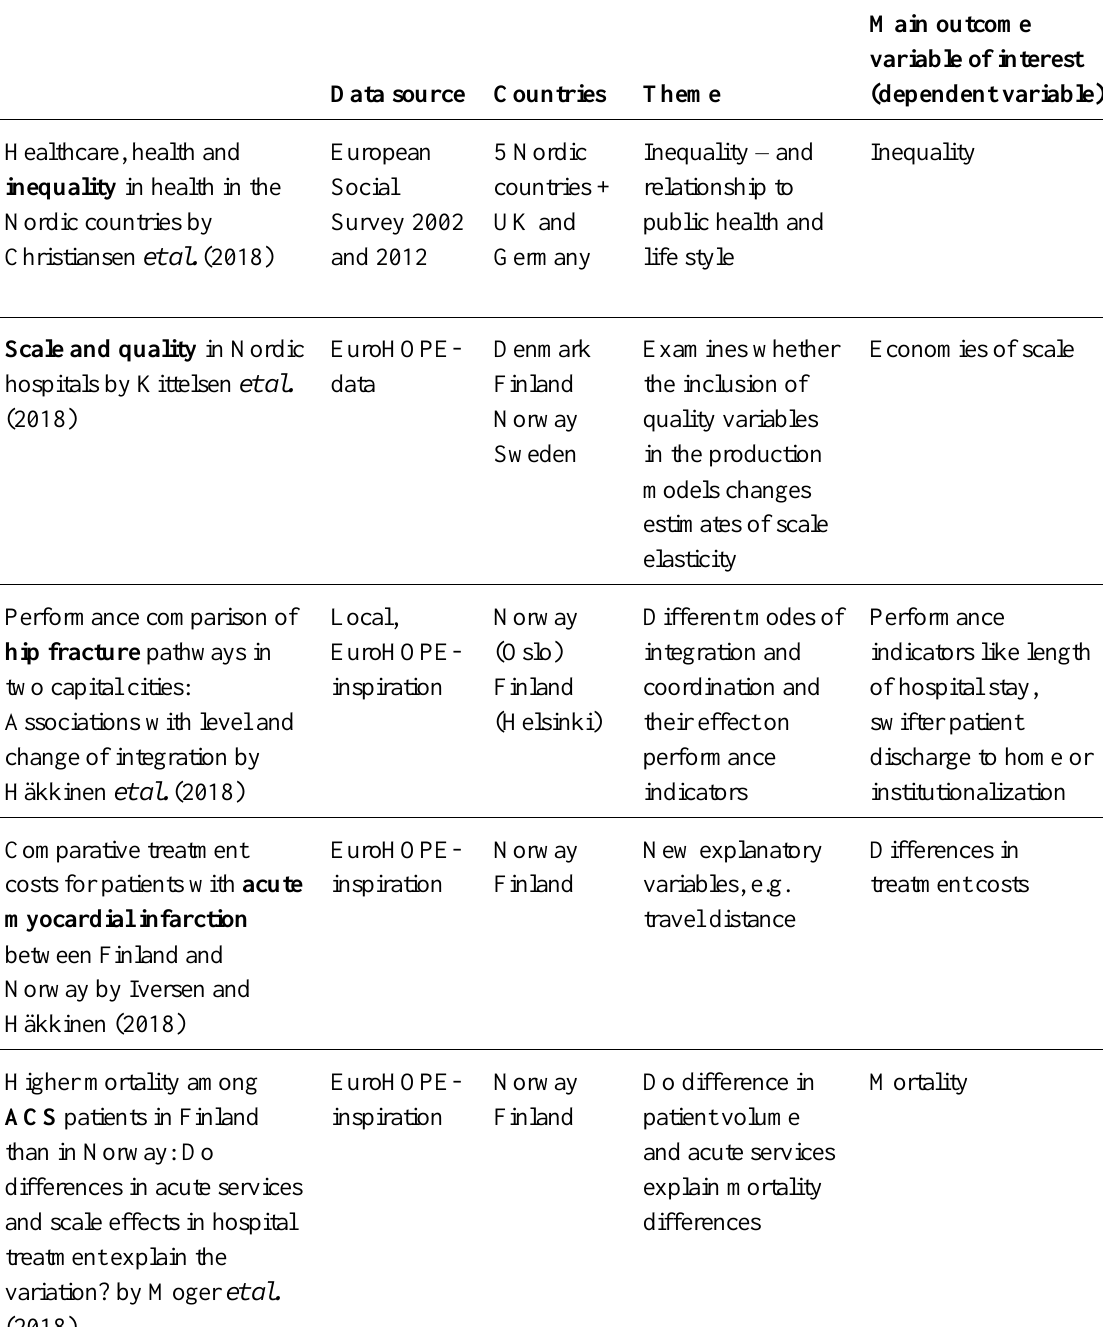
Table 1: Overview of the articles